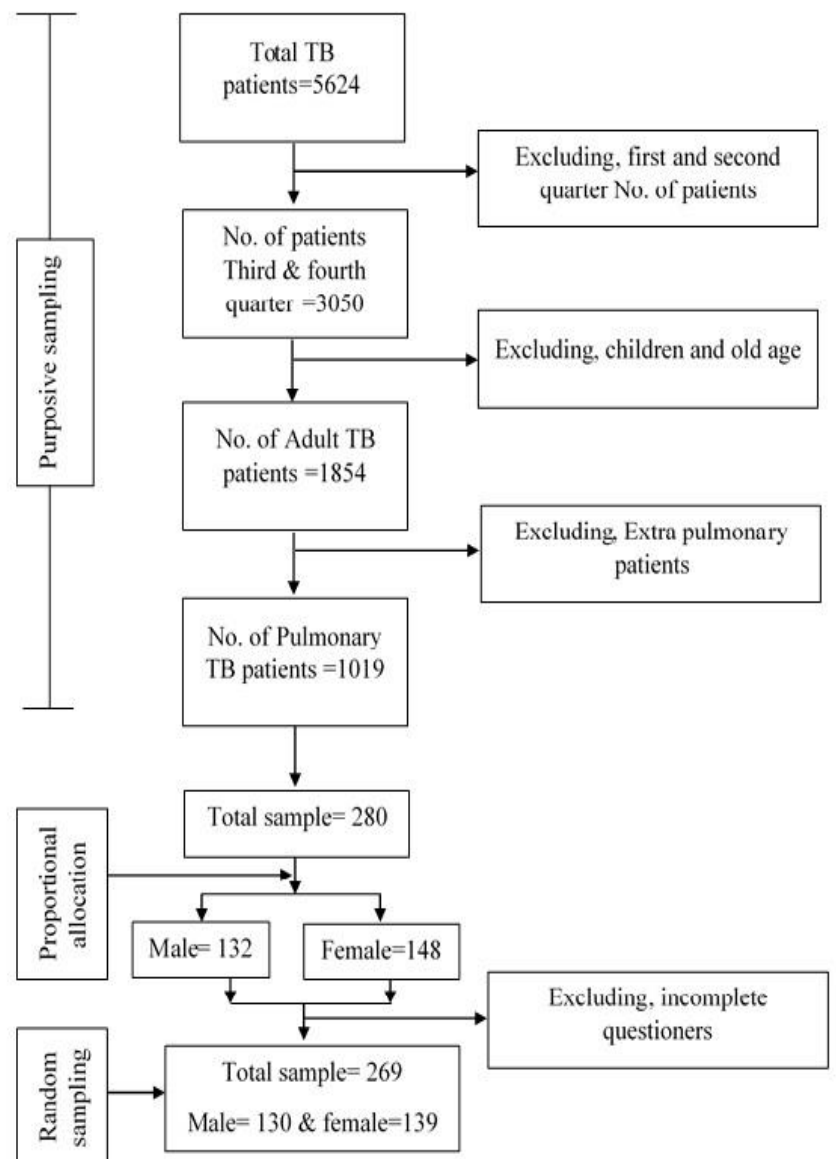
Figure 4. Flow chart of sampling.